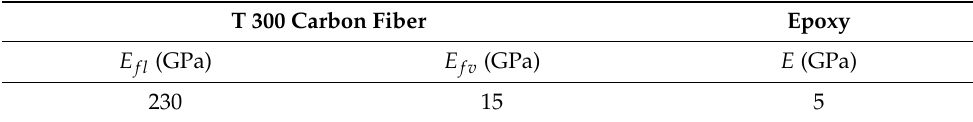
Figure 3. Different orientations of open-hole unidirectional composite plates with ( a ) 0 ◦ fiber direction, ( b ) 90 ◦ fiber directions ( c ) 45 ◦ fiber direction Table 1. The material properties of the unidirectional composite